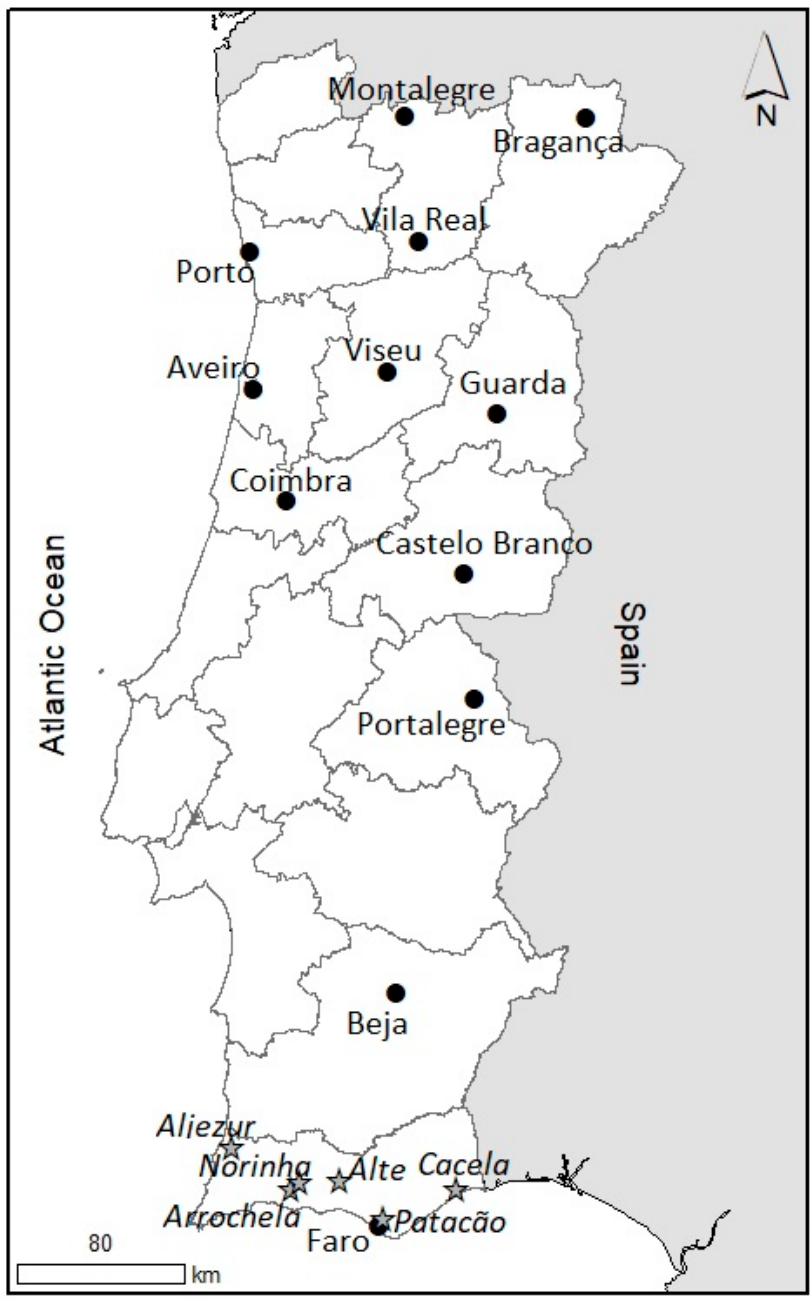
Figure 1. Portuguese Institute of the Sea and Atmosphere (black circles, IPMA) and Regional Directorate for Agriculture and Fisheries of Algarve (stars, DRAP Algarve) weather stations.